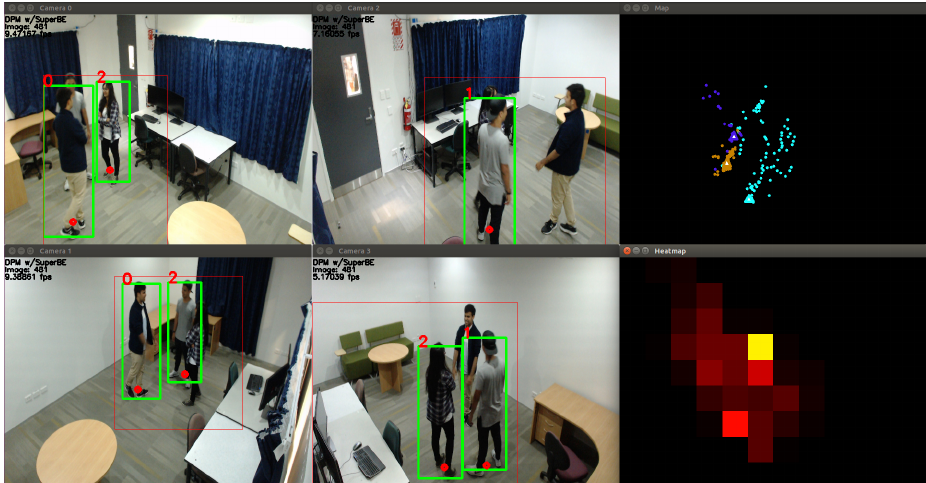
Figure 8. A group of people being tracked, with an erroneous classification due to the people standing closely together and the model fusion algorithm failing to separate the individuals. This figure follows the same annotations and mapping structure as Figure